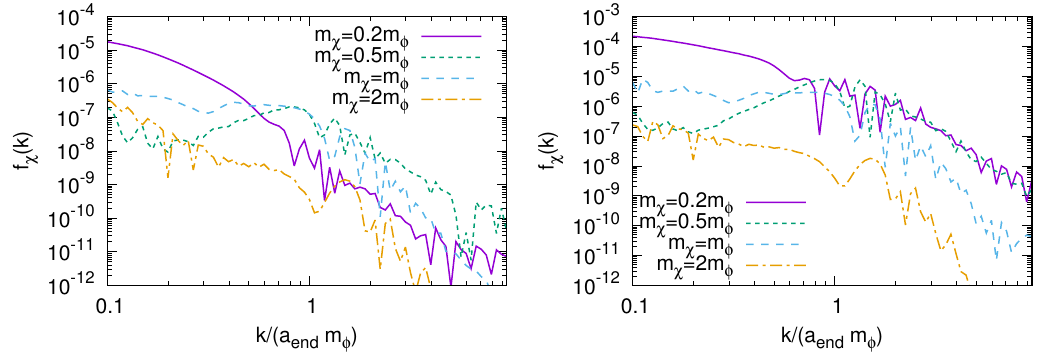
Figure 1 . The phase space density of (cid:31) after the gravitational particle production in